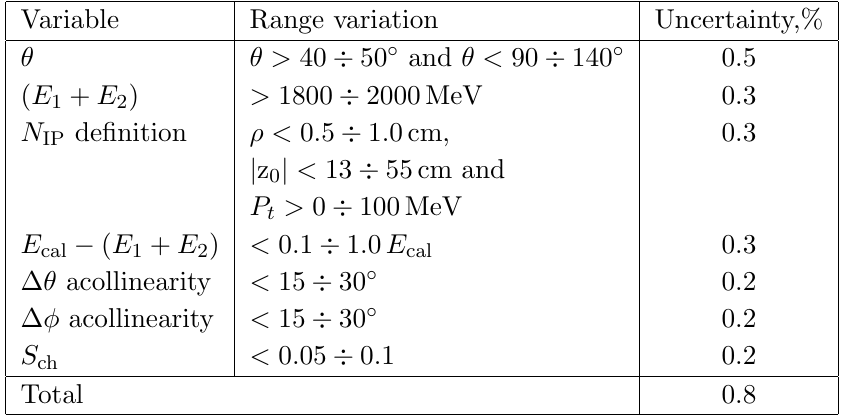
Table 3 . Uncertainties in % due to variation of the selection criteria for e + e (cid:0) events. corresponding (cid:0) ee ( J= ) and (cid:0) ee ( J= ) (cid:1)B hadrons ( J= ) width uncertainties were about 0.04% and (cid:0) ee ( J= ) (cid:1) B ee ( J= ) uncertainty was about